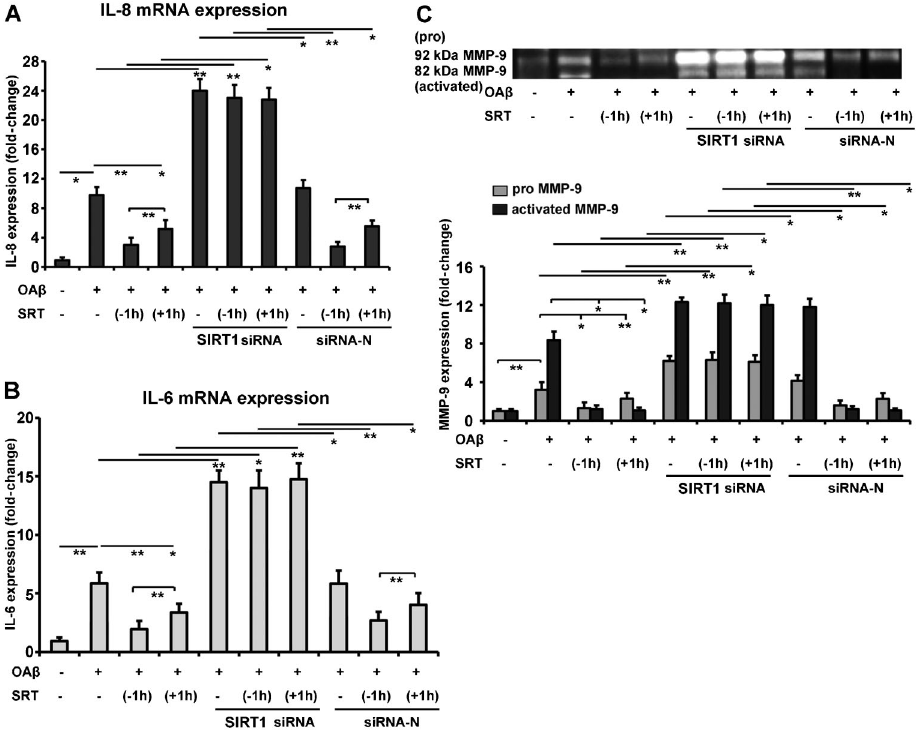
Figure 3. Effects of A b , SRT1720 and knockdown of SIRT1 on IL-8, IL-6 and MMP-9 expression in RPE cells. A , PCR analysis of IL-8 mRNA expression. B , PCR analysis of IL-6 mRNA expression. C , Gelatin zymography assay of MMP-9 expression. Stimulation with 0.3 m M OA b for 24 h induced significant increases in mRNA expression of IL-6, IL-8 and MMP-9 in RPE cells. Pretreatment with SRT1720 markedly attenuated OA b -induced increases of IL-6, IL-8 and MMP-9 expression. Knockdown of SIRT1 gene expression by SIRT1 siRNA significantly intensified the proinflammatory effects of OA b . Data are from three representative experiments. *P , 0.05, **P , 0.01 (unpaired t -test and